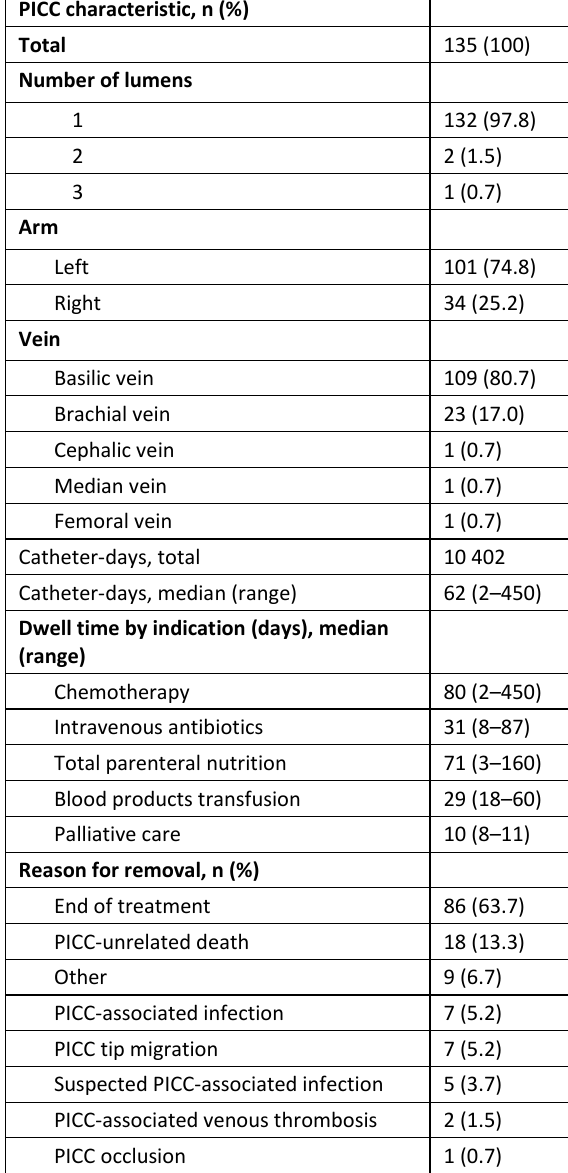
Table 2: Catheter data for the 135 devices inserted during the peripherally inserted central catheter (PICC) pilot pro-